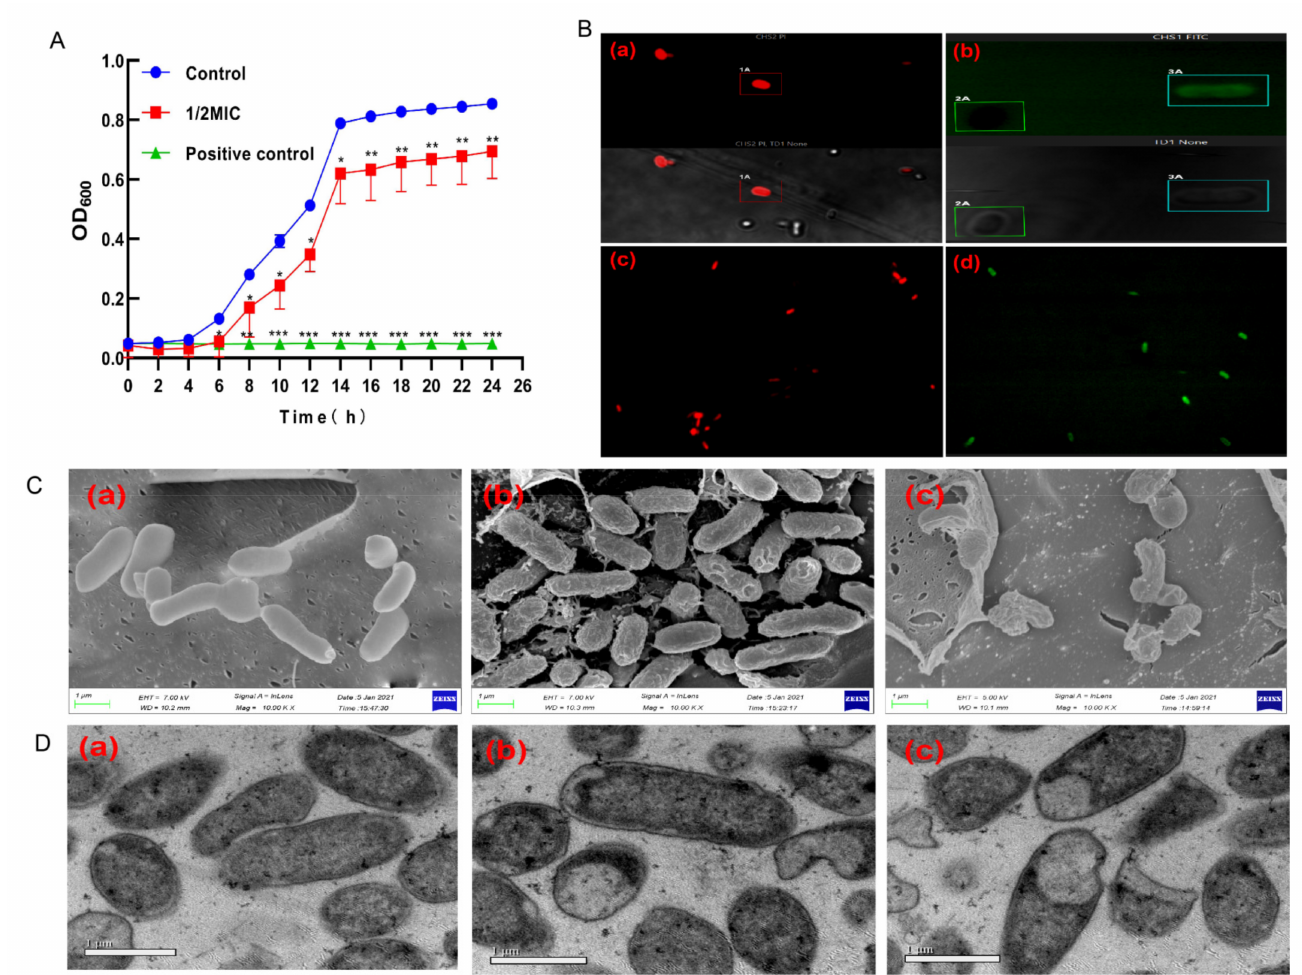
Figure 1. Damage effect of BCp12 to Escherichia coli cell membrane. ( A ) Growth curves for E. coli cultured in sterile water and 1/2 MIC BCp12. Note: compared with the control group, *, p ≤ 0.05; **, p ≤ 0.01; ***, p ≤ 0.001. Each value represents the average of three independent measurements. ( B ) Effects of BCp12 on cell membrane integrity of E. coli via CLSM. The E. coli cells treated with 1 MIC BCp12 (( a , b ) represent the bright field and fluorescence image; ( c , d ) represents the image under the fluorescent field). ( C ) SEM analysis of Escherichia coli under different treatments; ( a )—the cells in the untreated E. coli ; ( b )—the cells after treatment with 1/2 MIC BCp12; ( c )—the cells treated with 1 MIC BCp12; ( D ) TEM analysis of Escherichia coli under different treatments. ( a ) Untreated E. coli . ( b ) E. coli treated with 1/2 MIC BCp12. ( c ) E. coli treated with 1 MIC